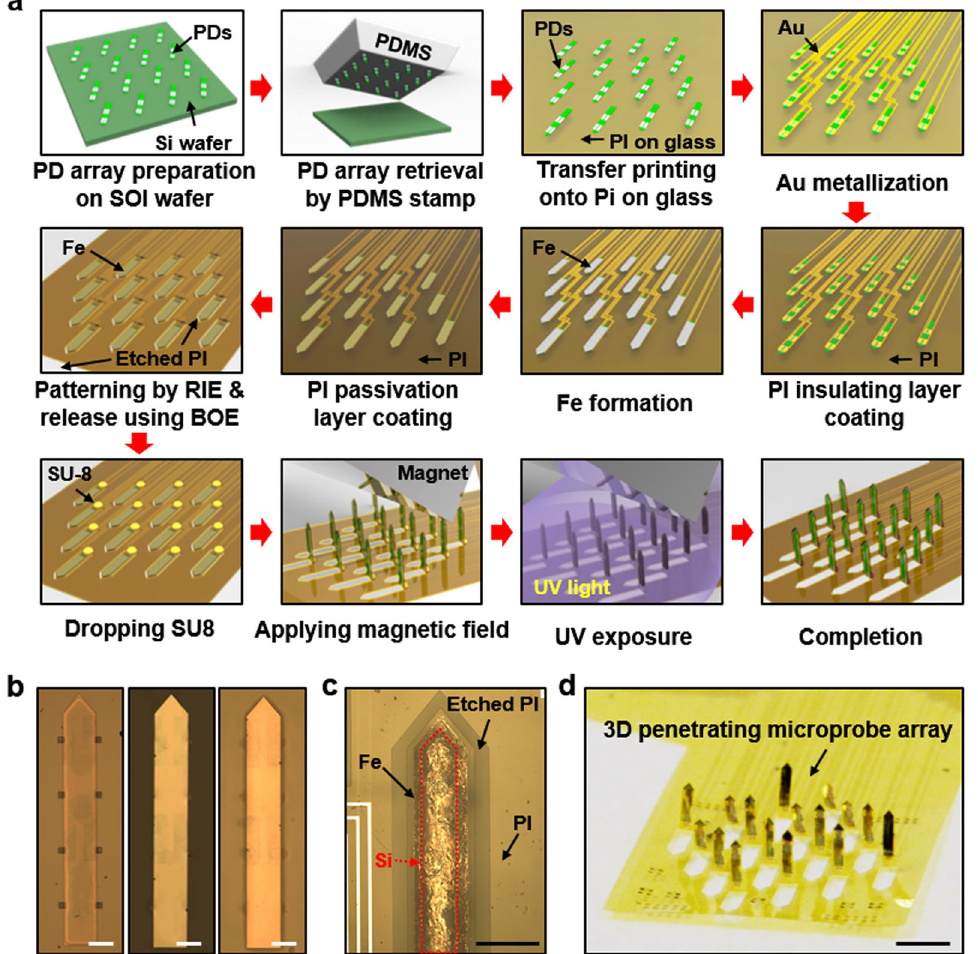
after transfer printing. (scale bar, 200 μ m). c An optical image of completed single microprobe after isolation. (scale bar, 500 μ m) d An optical image of a fabricated penetrating microprobe array. (scale bar, 2 shown Fig. 3g. The dark current and photocurrent under illumination have a negligible decrease at relativly large bending radii (e.g. >8 mm), yet decrease up to 7.9% once the bending radius is down to 1.3 mm. Although the photocurrent and dark current slightly decreased as a result of bending, the ratio between them remained invariant, as shown in blue line on Fig. 3g. Analytical studies based on a simpli fi ed multilayered beam model were performed to extract the mechanical strain in the Si. A multiple layered composite structure is modeled, as shown in Supplementary Fig. 5. The detailed analysis is described in supporting information. The calculated strain of the Si (along the top, middle, and bottom planes) is plotted in Supplementary Fig. 6. At a bending radius of 1 mm, the strain along the middle plane is about 0.05% and the maximum tensile strain is about 0.11%. The results indicate that no mechanical fracture in the brittle Si would occur since the bending induced strain is far less than the fracture limit (1%) of Si. Together with its mechanical reliability, the stable current ratio under bending conditions suggests that the optoelectronic microprobes is feasible to capture the photo intensity even though they are deformed after future insertion.